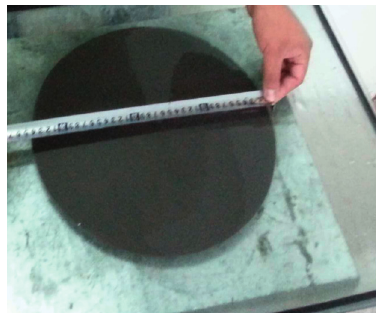
Figure 7: Measurement of net slurry